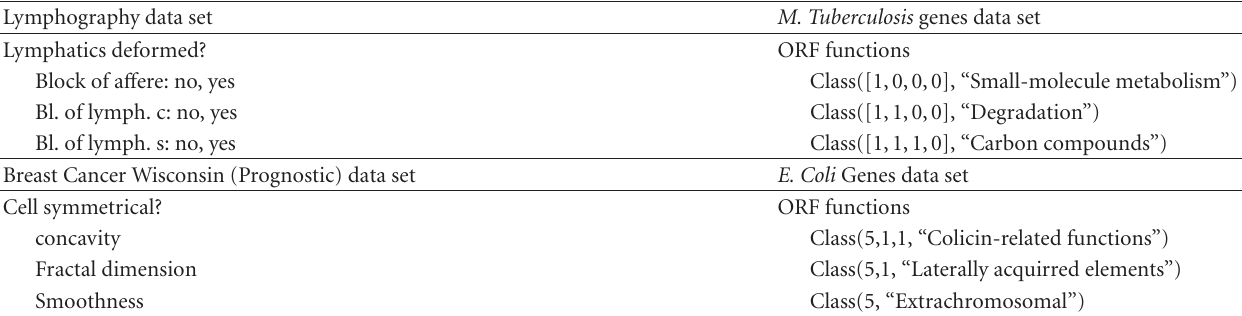
Table 1: Examples of aggregation on binary variables in UCI medical